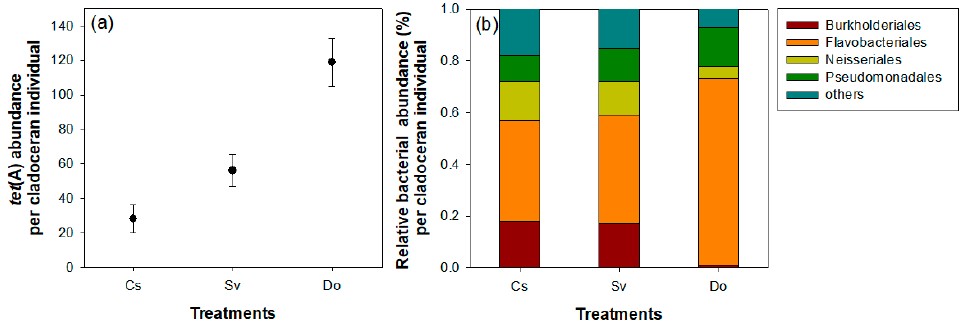
Figure 2. The tet (A) abundance ( a ) and relative bacterial abundance (%) ( b ) in each cladoceran individual. Cs, Chydorus sphaericus ; Sv, Simocephalus vetulus ; Do, Daphnia obtusa .